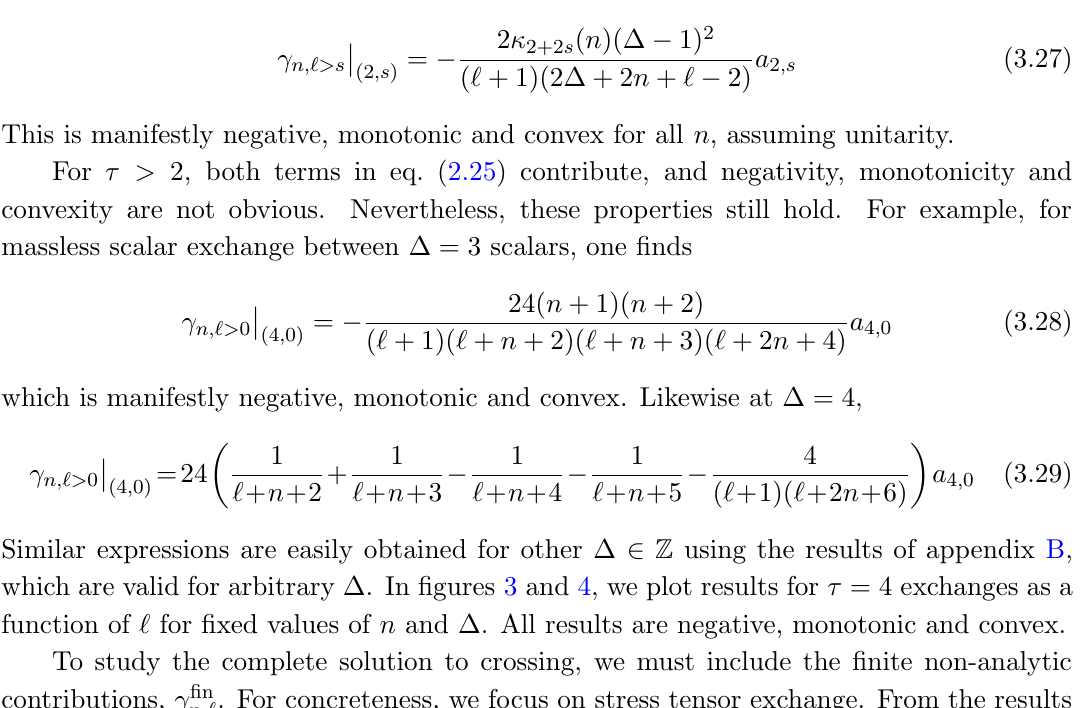
Figure 3. The asymptotic contribution due to massless scalar exchange, (cid:13) as of n and (cid:1). In both plots, (cid:1) = 4 + 2 m for 0 (cid:20) m (cid:20) 10; the red line is (cid:1) = 4, with increasing (cid:1) as we move downwards through the rainbow. The left plot is at n = 1. The right plot is at integer 100 (cid:20) n (cid:20) 104, where each thick line is comprised of (cid:12)ve individual lines. In all cases, the result is negative, monotonic and